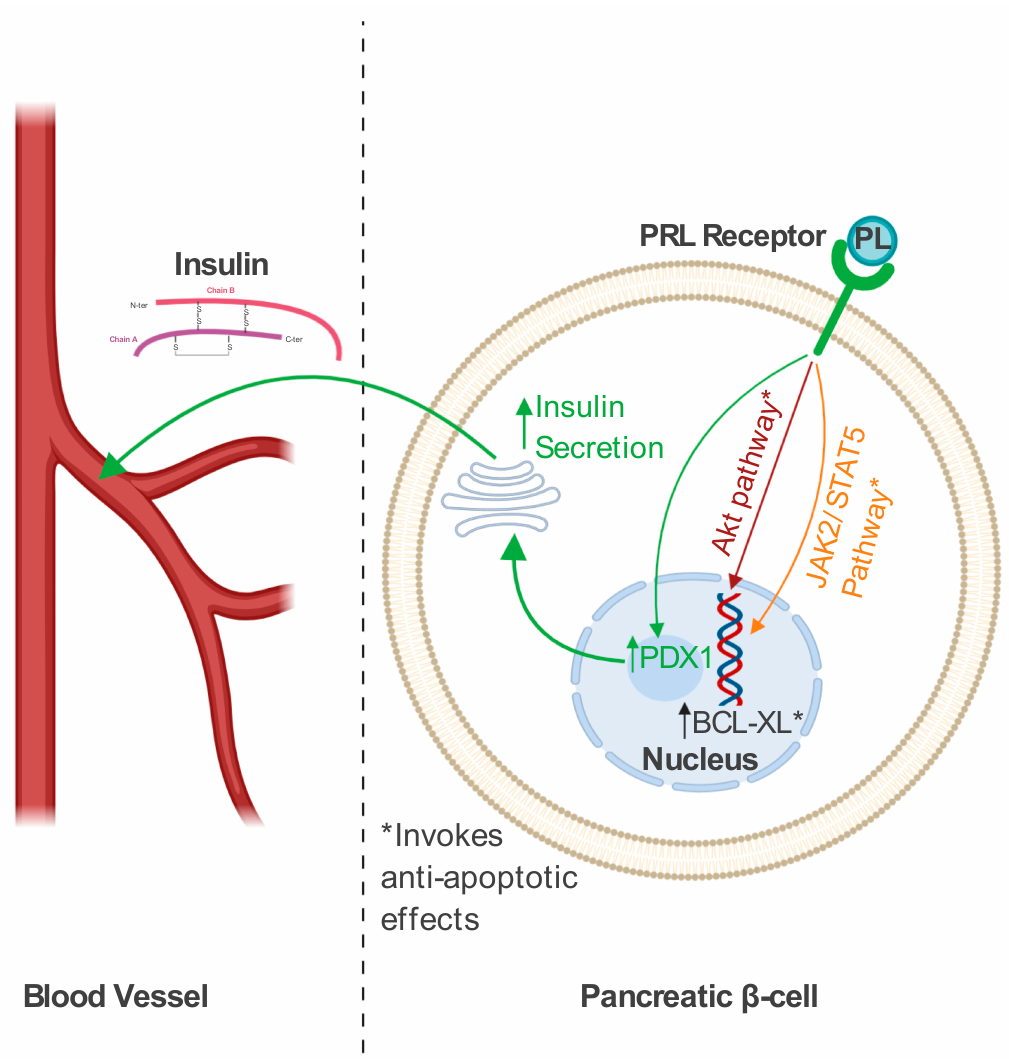
Figure 1. The mechanisms of the biological activity of placental lactogen (PL) in pancreatic β -cells. PL binds to the prolactin receptor (PRL Receptor) to promote increased insulin secretion through the stimulation of pancreatic and duodenal homeobox 1 (PDX1) expression. PL also activates a range of intracellular pathways (the Janus-activated-kinase-2/signal transducer and activator of transcription-5 (JAK2/STAT5) pathway and the phosphorylation of protein kinase B (AKT)) to protect β -cells from apoptotic death. Independently from the mechanisms mentioned above, PL contributes to increased expression of the BCL-XL anti-apoptotic protein [43–46]. Created with BioRender.